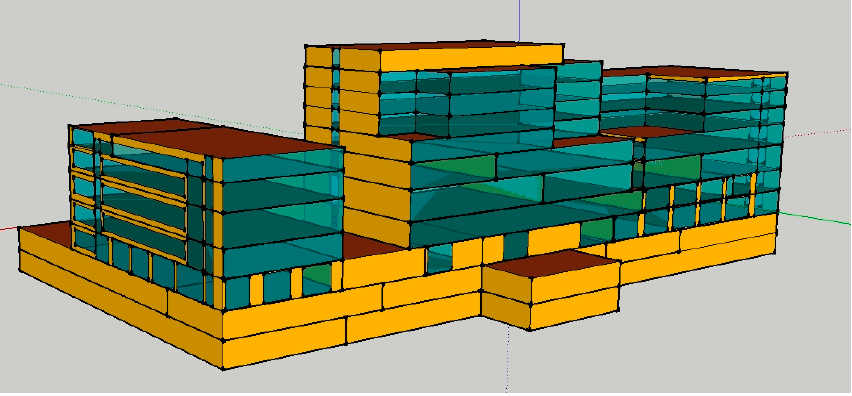
Figure 2. Target building TRNSYS 3D modeling. Table 5. Geothermal heat pump and absorption chiller and heater data information.